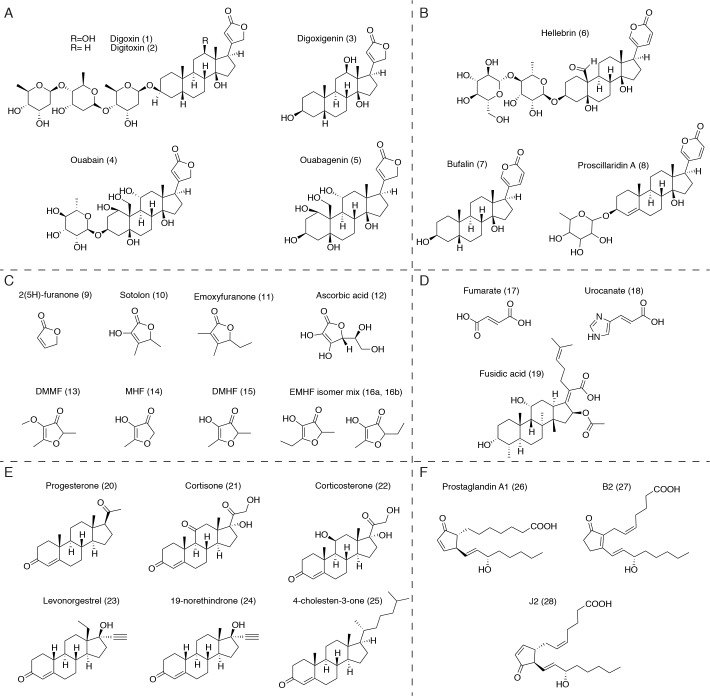
Putative substrates for Cgr2 in the context of the human gut.(A) Plant-derived cardenolides. (B) Bufadienolides. (C) Dietary furanones, including sotolon (4,5-dimethyl-3-hydroxy-2,5-dihydrofuran-2-one), emoxyfuranone (5-ethyl-3-hydroxy-4-methyl-2(5 hr)-furanone), DMMF (2,5-dimethyl-4-methoxy-3(2 hr)-furanone), MHF (4-hydroxy-5-methyl-3-furanone), DMHF (4-Hydroxy-2,5-dimethyl-3(2 hr)-furanone), and EMHF (5-ethyl-4-hydroxy-2-methyl-3(2 hr)-furanone). (D) α,β-unsaturated carboxylic acids, including the antibiotic fusidic acid and substrates of similar bacterial reductases. (E) Ketosteroids, including naturally occurring hormones, synthetic steroid drugs, and putative cholesterol metabolites. (F) Unsaturated prostaglandins involved in host inflammation.